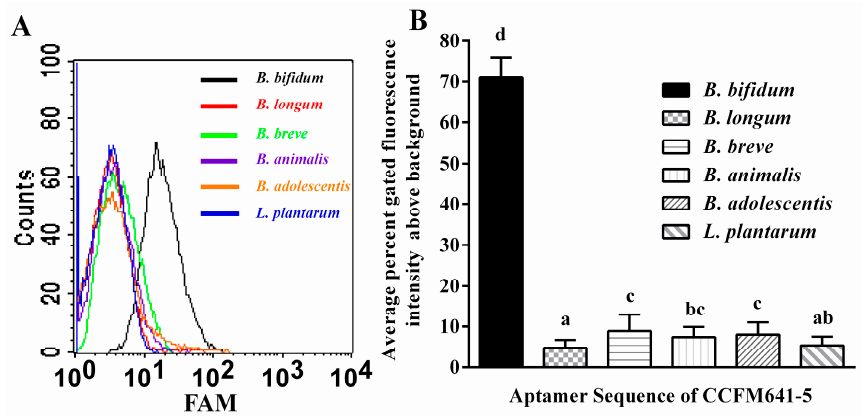
Figure 3. Characterization of the specificity of aptamer CCFM641-5 for B. bifidum . Selected aptamer sequence CCFM641-5 preferentially bound to B. bifidum over other species of bacteria. ( A ) Flow cytometric analysis of aptamer CCFM641-5 binding for different species of bacteria which are shown with differently colored curves; ( B ) Histogram of the percent gated fluorescence intensity above background for aptamer CCFM641-5. The values of aptamer binding represent the mean ± SD of three independent experiments. Bars with different letters are significantly different ( p < 0.05).